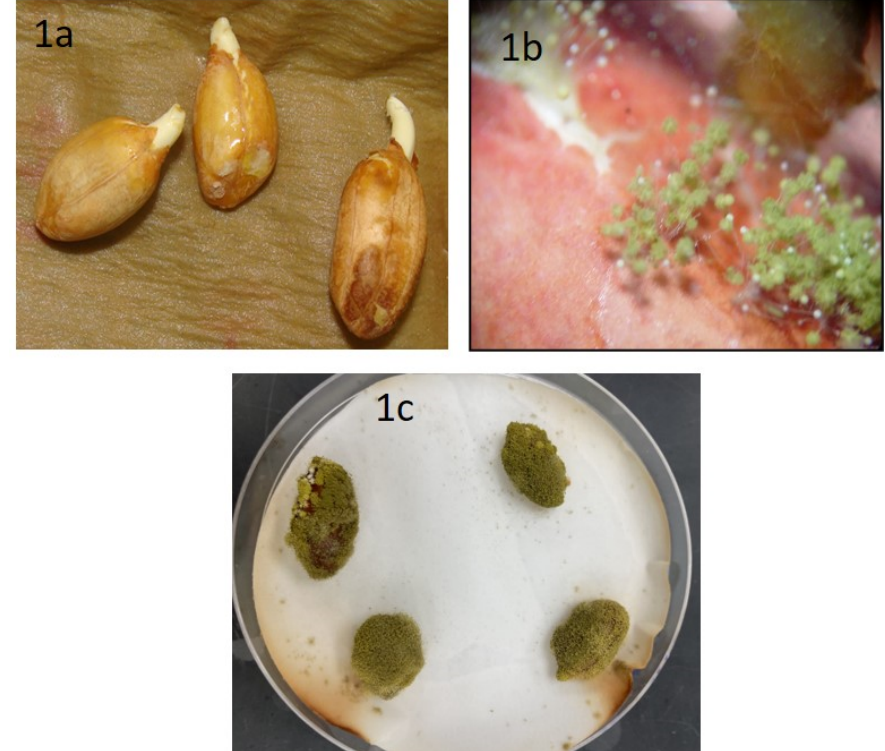
Figure 1. Isolation and screening of A. flavus from peanut seeds, variety Tifguard. Image of ( a ) healthy peanuts, ( b ) fungus sporulation from infected peanuts under light microscopy examination, and ( c ) peanuts infected with A. flavus , incubated for 7 days in moist filter paper.